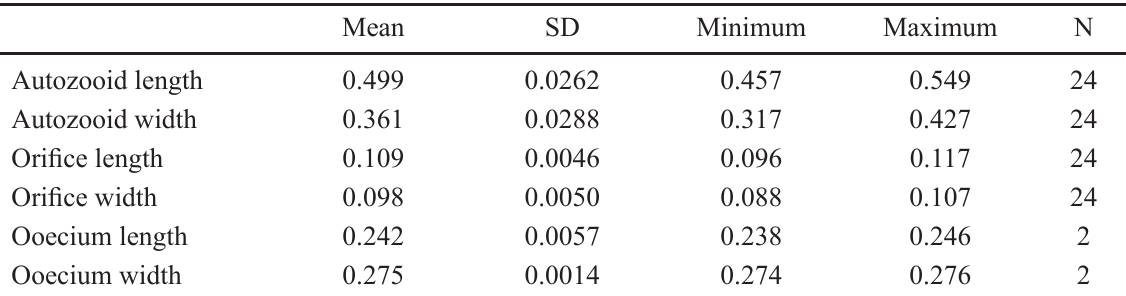
Table 3. Measurements (in mm) of Escharella guernei (Jullien & Calvet, 1903) comb. nov. (lectotype). SD = standard deviation; N = number of